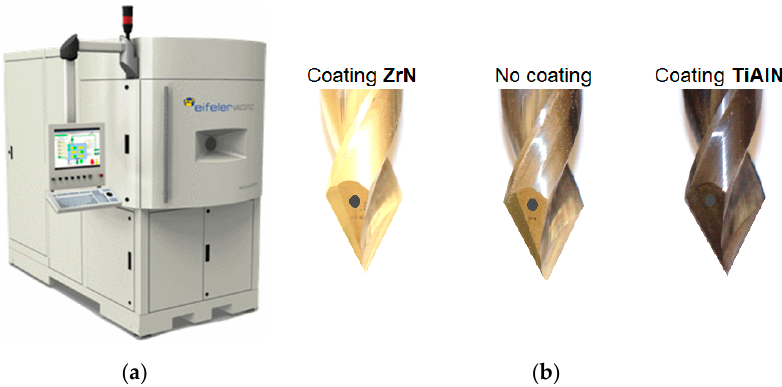
Figure 6. Stand for applying protective coatings: ( a ) Vacuum reactor EIFELER VACOTEC PVD Alpha 400; ( b ) drills with the coatings used in the research.